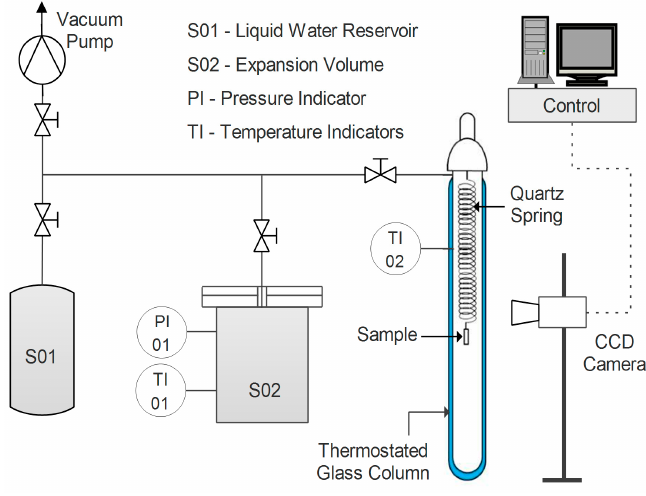
Figure 1. Layout of the quartz spring microbalance used to measure water vapor uptake.